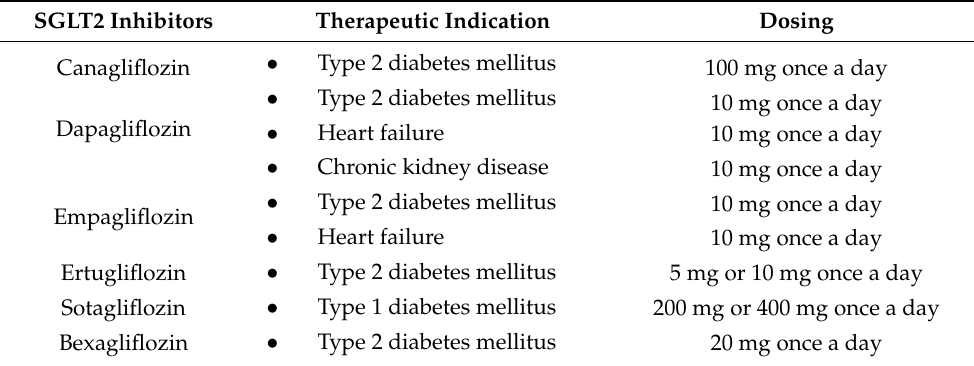
Table 1. Pharmacological characteristics of SGLT2 inhibitors available in the market. SGLT2